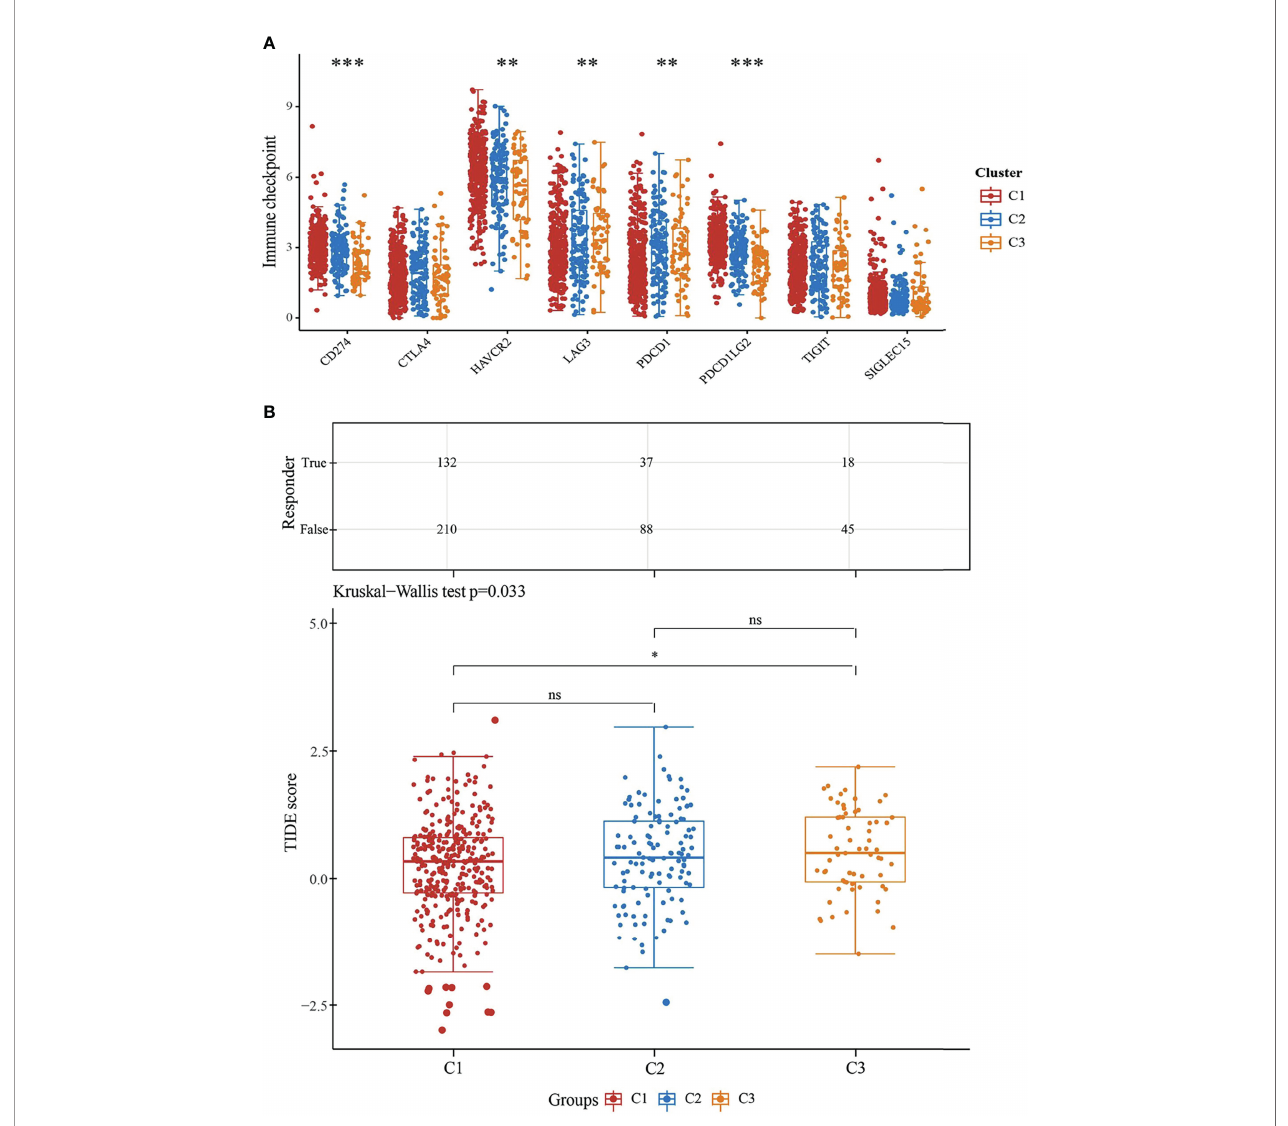
FIGURE 6 | Predictive ICB response of ccRCC subgroups. (A) Expressions of eight immune checkpoint molecules in three subgroups. The signi fi cance of the three groups and above passed the Kruskal – Wallis test. (B) Statistical table of immune response samples (upper) and the distribution of immune response scores (underneath) in ccRCC subgroups in prediction. **P < 0.01, ***P < 0.001, ns, no signi fi